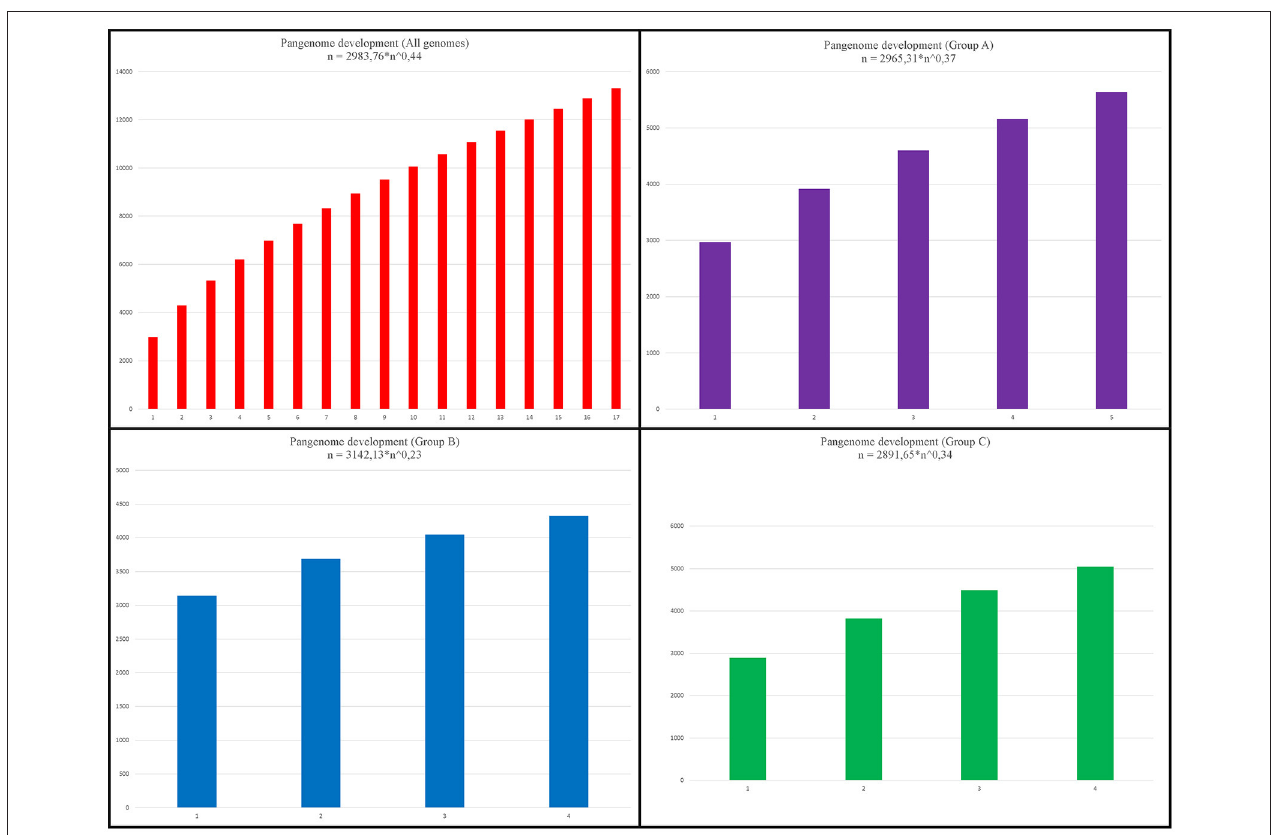
FIGURE 6 | Pangenome development. Upper left chart: pangenome development based on permutations of all 17 genomes of Faecalibacterium . Upper right chart: development based on permutations of 5 genomes from group A. Lower left chart: development based on permutations of 4 genomes from group B. Lower right chart: development based on permutations of 4 genomes from group